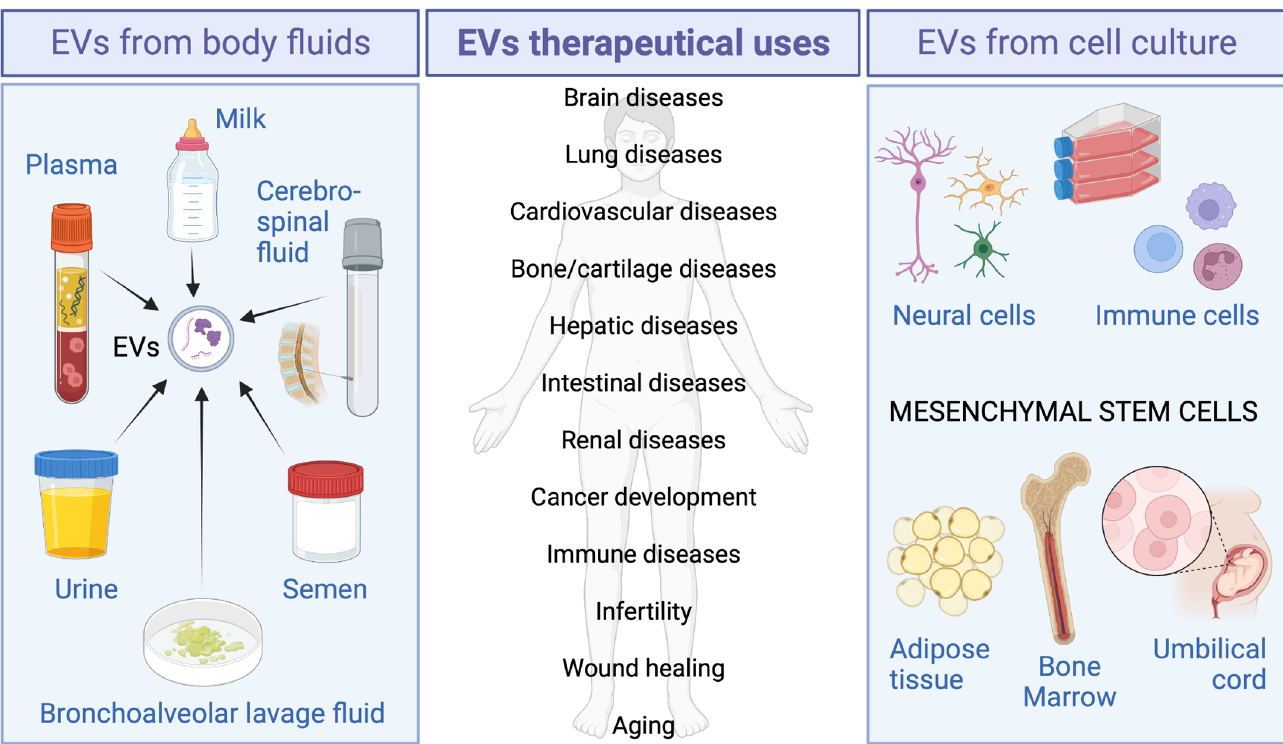
Figure 1. Most used cell sources for EVs obtention and their possible clinical applications.